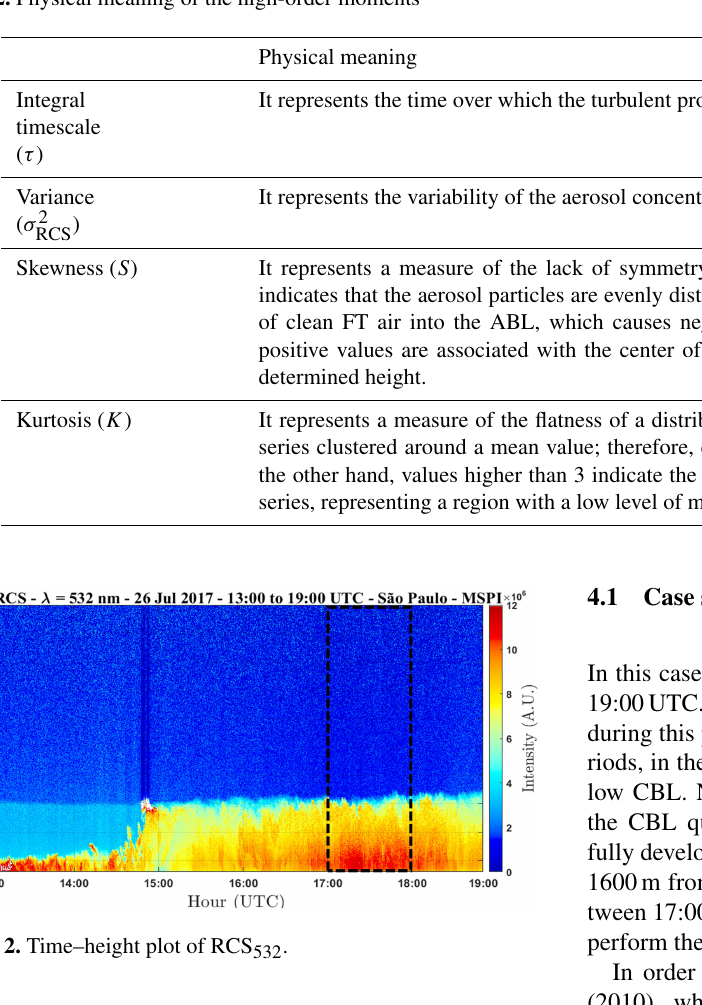
Table 2. Physical meaning of the high-order moments